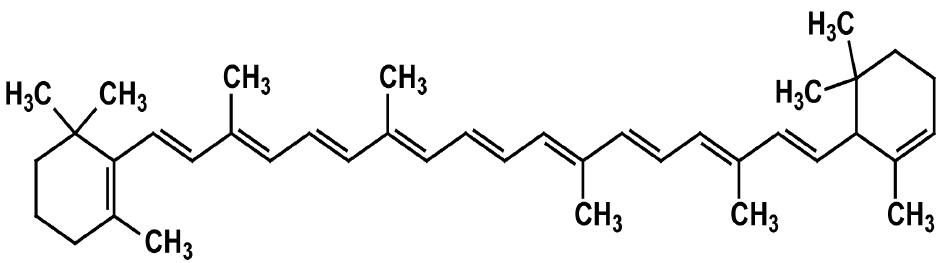
Figure 10. The structure of beta-carotene [169]. Table 1. Trivial name and semi-systematic names of